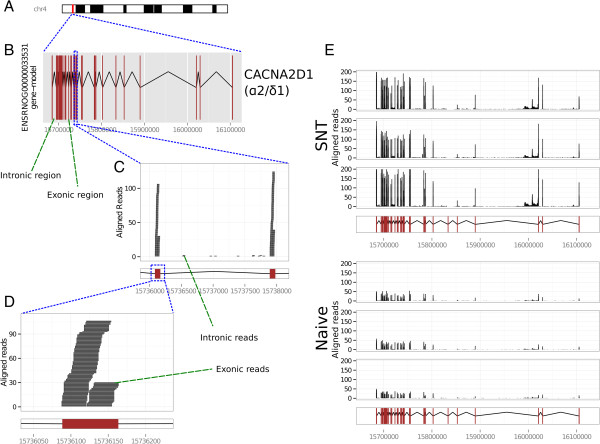
Example of a genome graph for the Cacna2d1 gene (Calcium channel, voltage-dependent, alpha2/delta subunit 1). A) The genomic location of the Cacna2d1 gene on chromosome 4, highlighted in red. B) The exonic/intronic structure of the gene; brown squares represent exons, the black links between them represent introns. C) A zoomed-in region of the gene, showing the positions where the sequenced reads align to the exons and introns of the gene (grey bricks), for a given RNA-seq sample (in this example, an SNT sample is shown, sequenced to a depth of 50 M reads). D) A further zoomed in region of the gene, showing the individual reads and the positions to which they align in greater detail. E) The genome graphs for all of the samples (shown for sequencing depth 50 M). Each row represents a different sample. When calculating fold change, the reads aligning to each exon are summed to produce the raw expression value for each sample, and then DESeq is used to compare these values between SNT and naive samples. Some reads align outside of known exons, this is explored further in the section “Intronic expression and its effect on fold change calculation”.